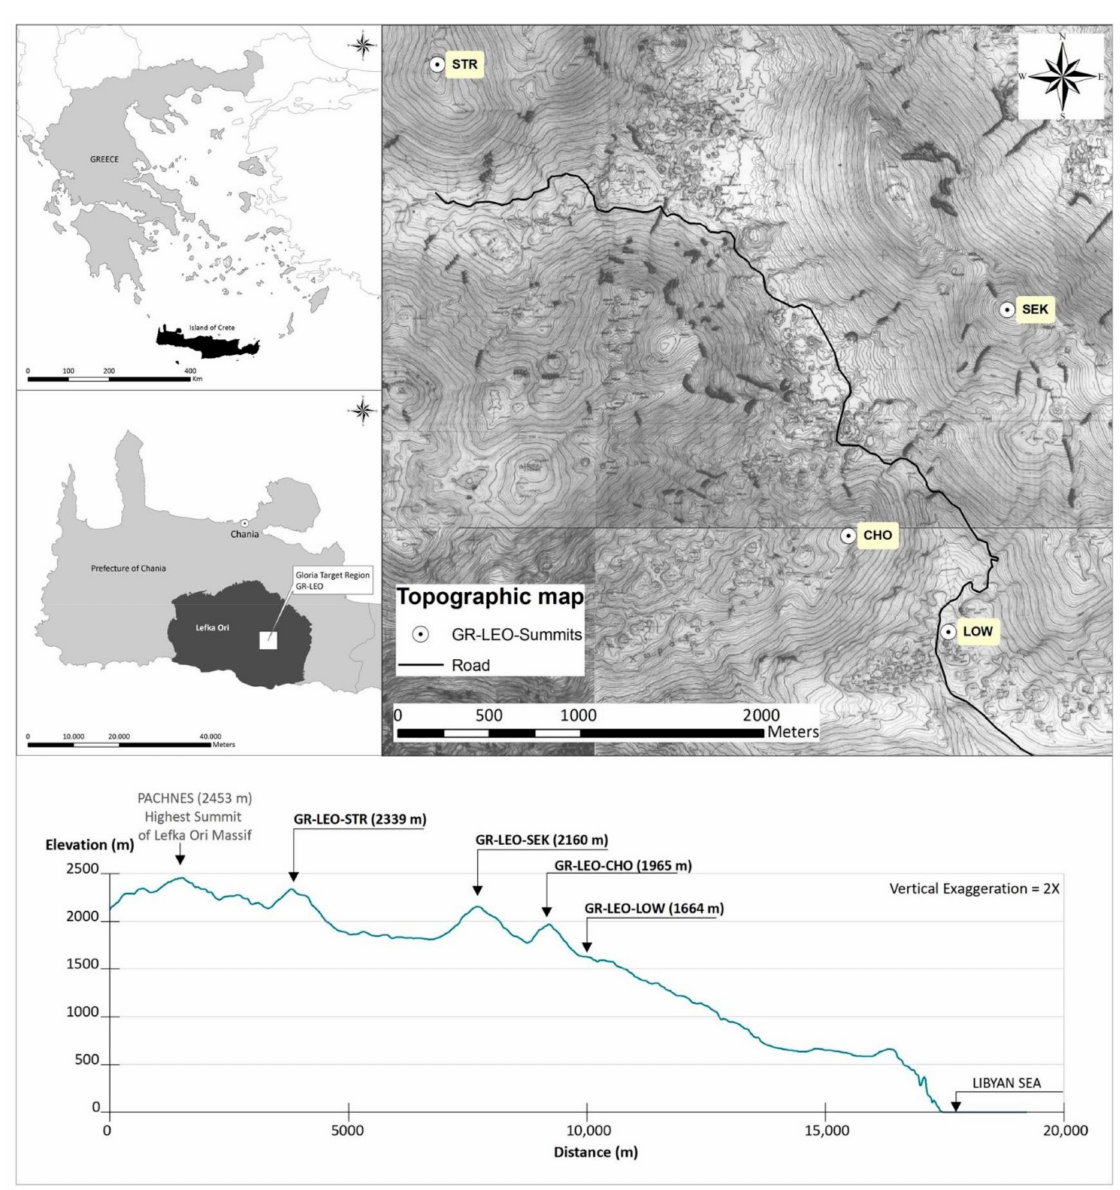
Figure 1. Topographic profile of South Lefka Ori massif and the four Gloria summits (GR-LEO). LOW: low summit, CHO: Chorafas, SEK: South East Kakovoli, STR: